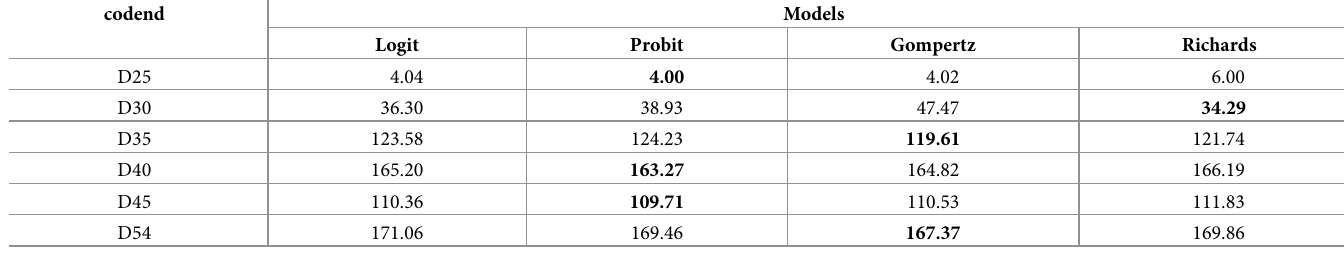
Selected model in